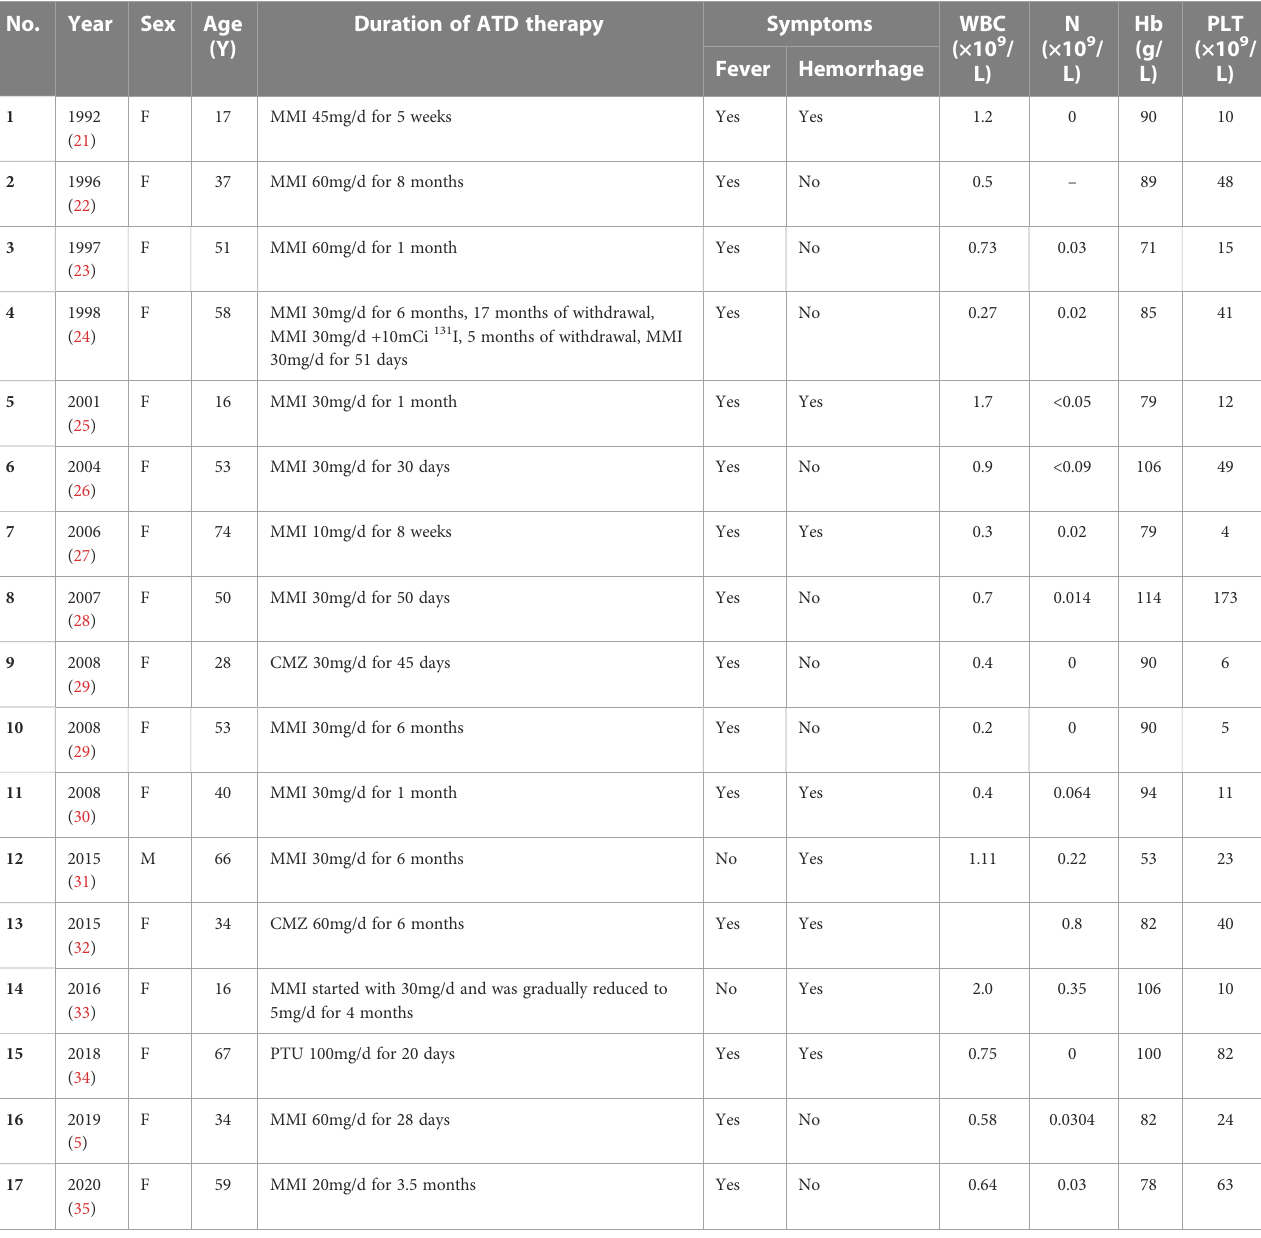
TABLE 1 Data summary of enrolled